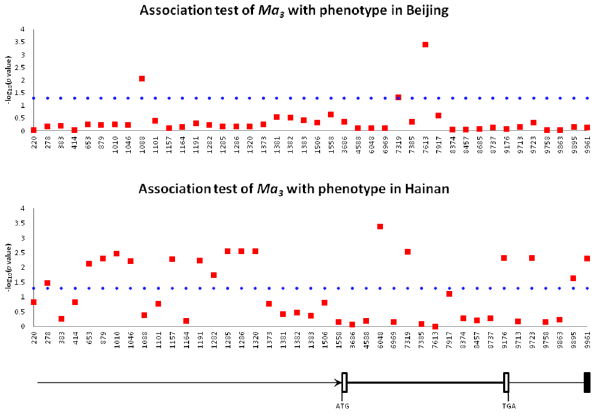
Fig 3. Association tests for Ma 3 . Red dot – supposed synthetic association site; blue dashed line – 5% significance threshold. Arrow bar — promoter region; thick line — the gene region from the